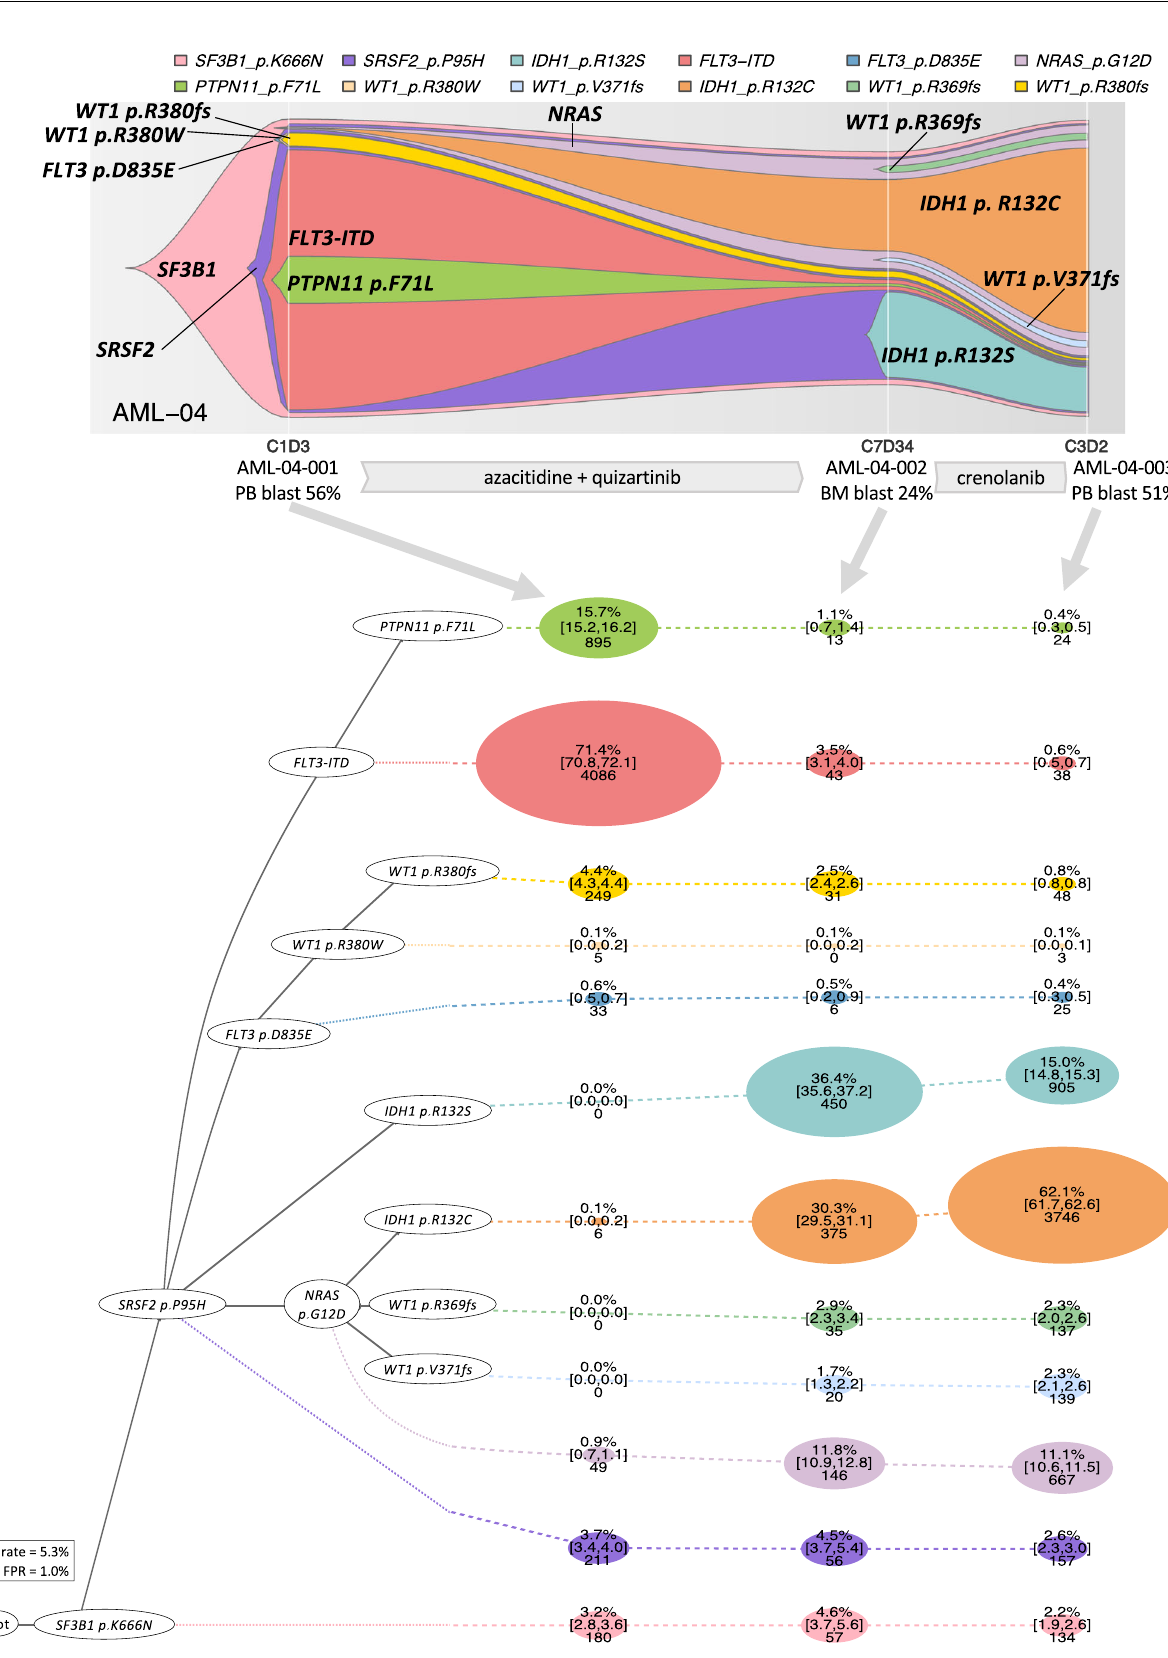
Fig. 9 Selection of IDH1/RAS clones during FLT3 inhibitor-containing therapy. A 76-year-old man with refractory secondary AML showing the clearance of FLT3 -ITD clone with an expansion of IDH/RAS clones during a FLT3 inhibitor-containing therapy. The fi sh plot shows the inferred clonal evolution pattern based on the single-cell genotype data. The phylogenetic trees visualize the estimated order of mutation acquisition and the proportion of subclones with a different combination of mutations at each timepoint. The wild-type cells which did not carry any driver mutations are not shown. C cycle, D day, ADO allele dropout, FPR false-positive rate. Full case description is available in Supplementary